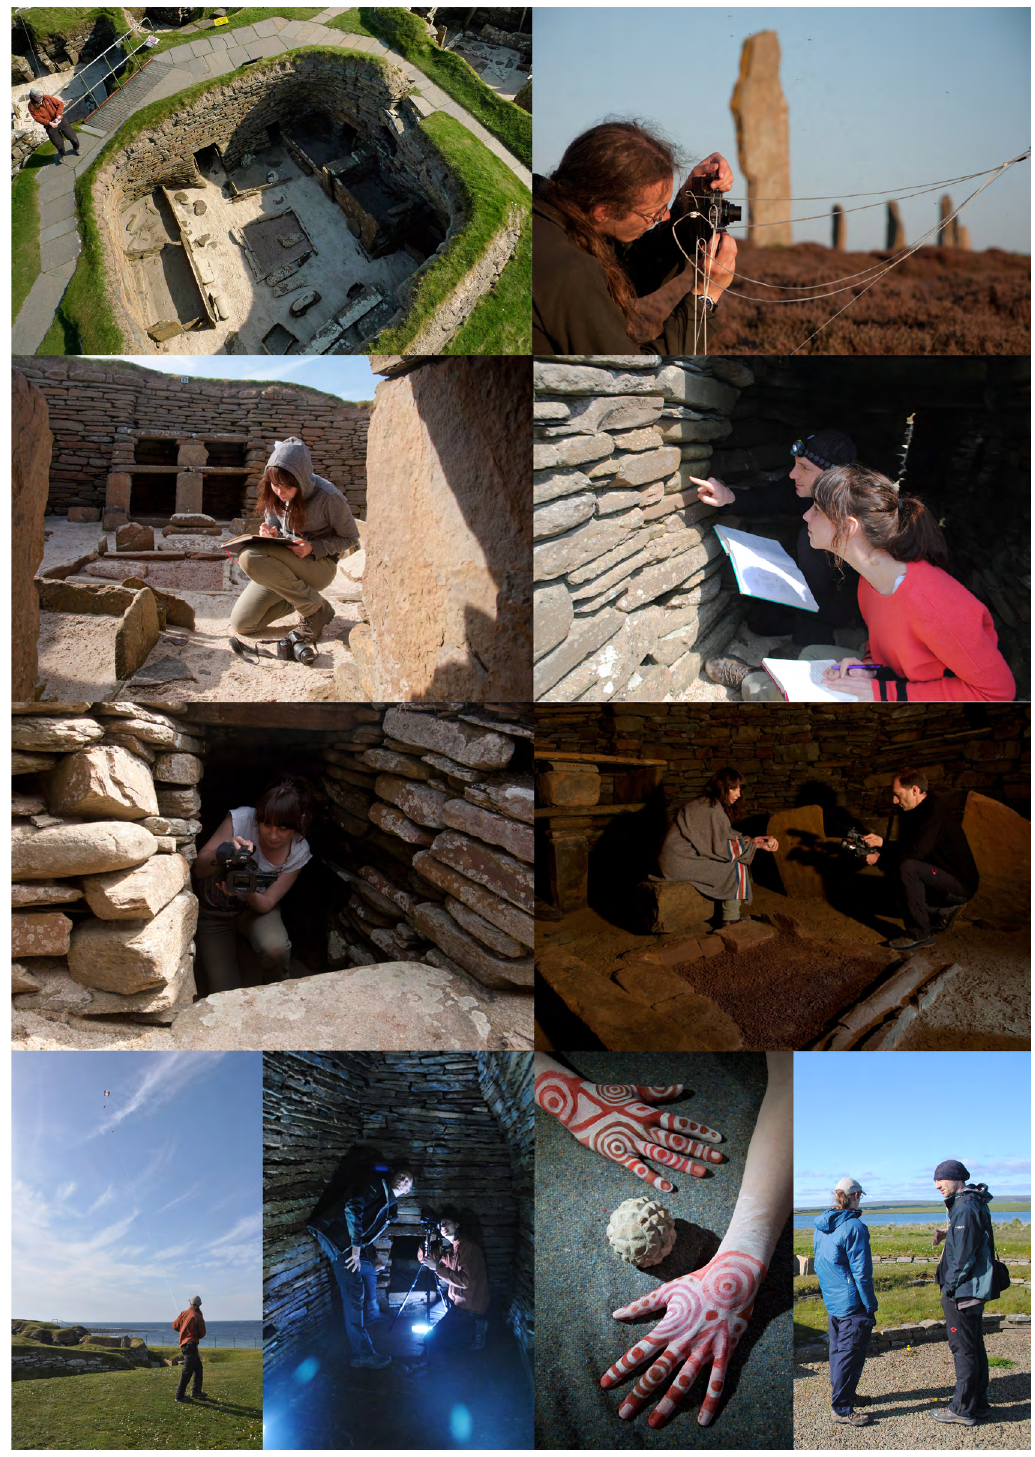
Figure 1: Select images from the Digital Dwelling fieldwork. From top left: kite photography at Skara Brae (photo by Kieran Baxter) and within the wider landscape at the Ring of Brodgar, recording paradata in the field (photos by Aaron Watson) and relating the relevant literature to features within the site (photo by Kieran Baxter), filming within the village (photos by Kieran Baxter), kite photography at Skara Brae (photo by Aaron Watson), conducting photogrammetry in the wider landscape at Cuween chambered tomb (author), the author’s painted hands with a replica carved stone ball during filming (photo by Aaron Watson) and a visit to the nearby Neolithic site of Barnhouse